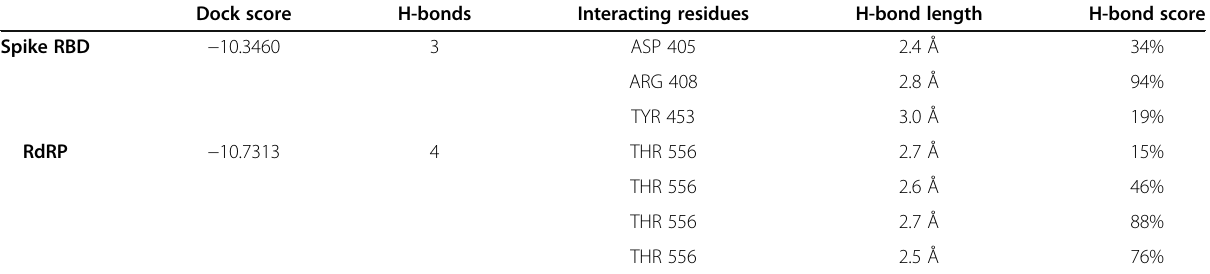
Table 2 Docking scores of andrographolide with SARS-CoV-2 spike RBD and with RNA-dependent RNA polymerase of